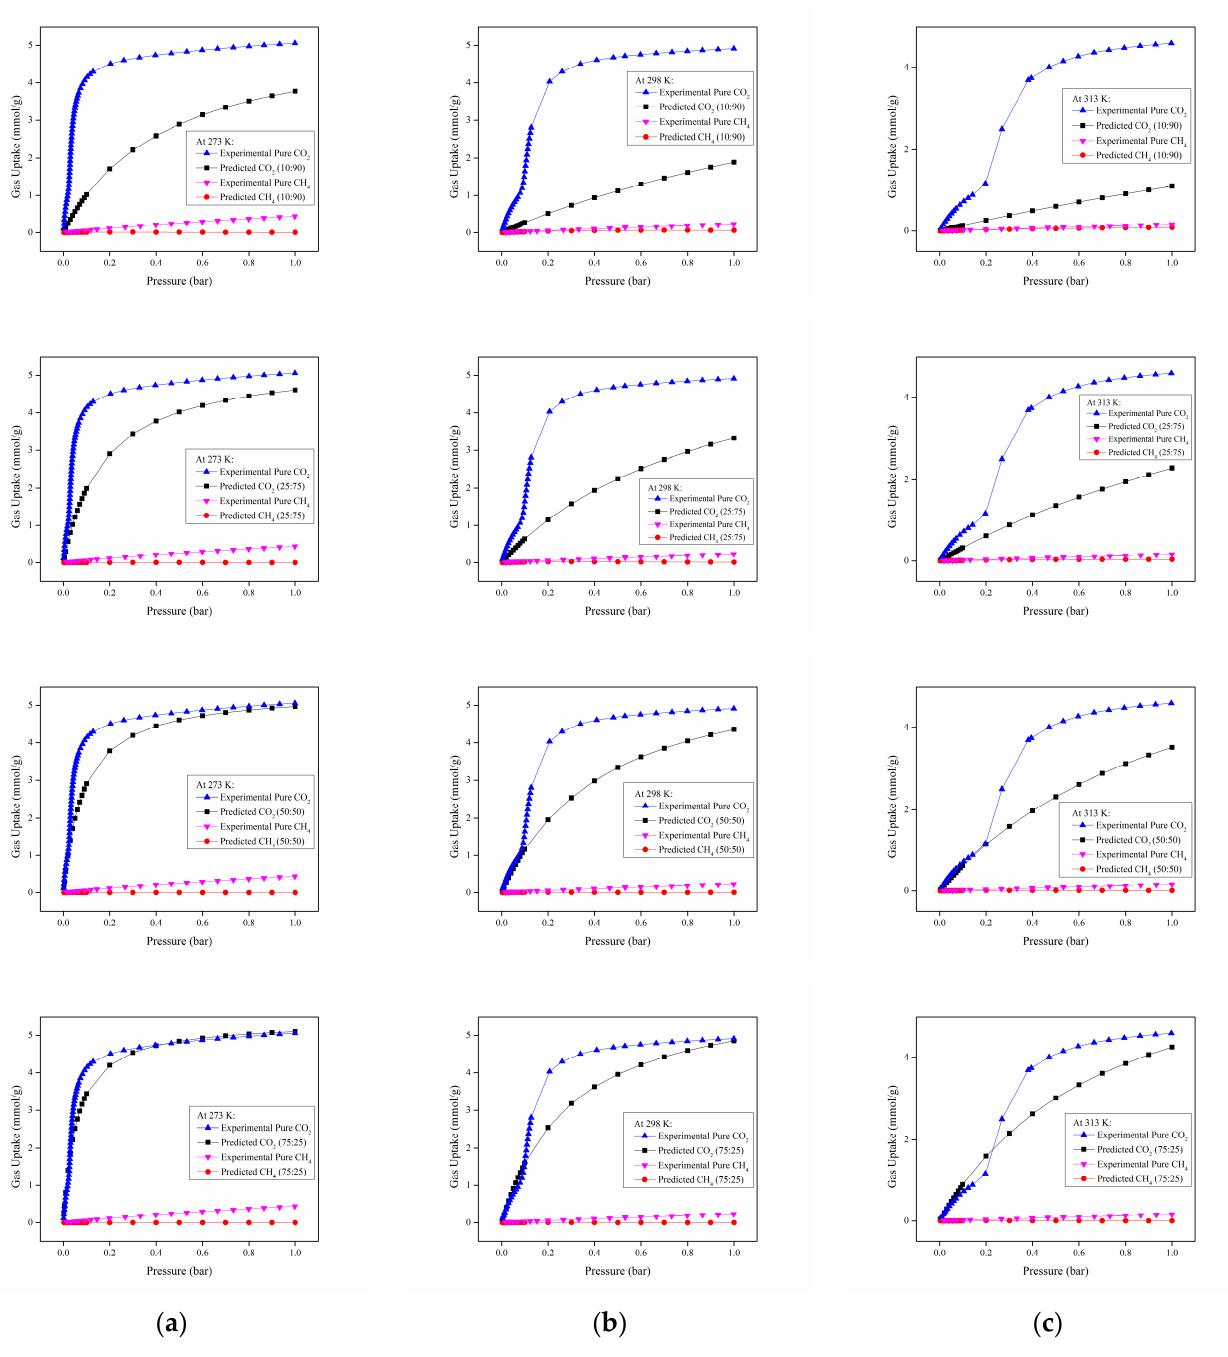
Figure 9. Experimental (single-component) and predicted (multicomponent) adsorption isotherms of CO 2 and CH 4 for 10:90. 25:75, 50:50 and 75:25 compositions at: ( a ) 273 K; ( b ) 298 K and ( c ) 313 K, respectively.